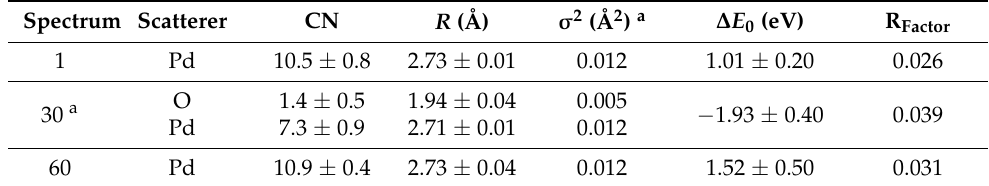
Table 1. Fit parameters for EXAFS spectra of 2 wt.% Pd/Al 2 O 3 acquired at 300 o C during CO and O 2